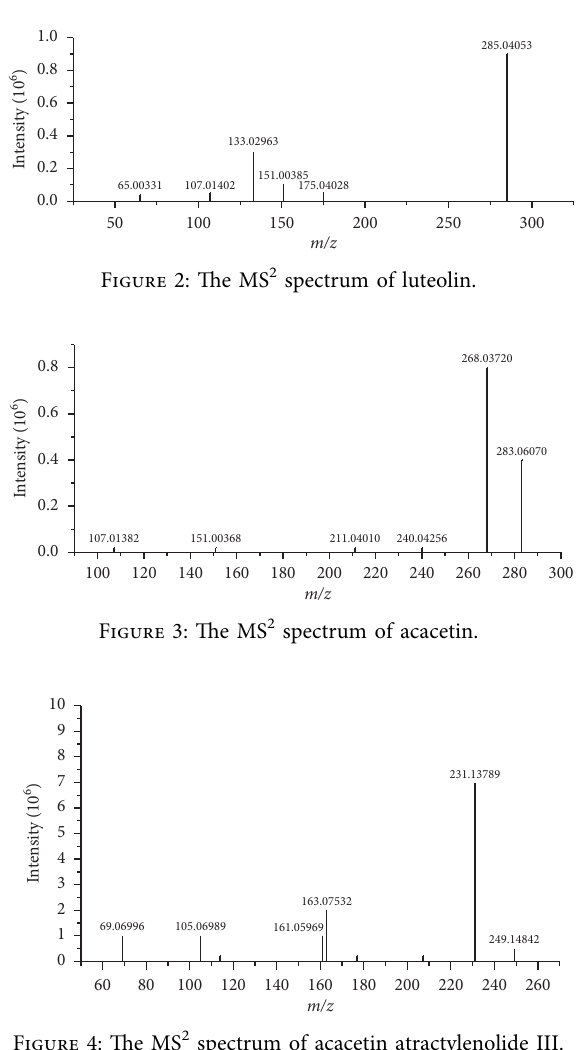
Figure 4: The MS 2 spectrum of acacetin atractylenolide III.